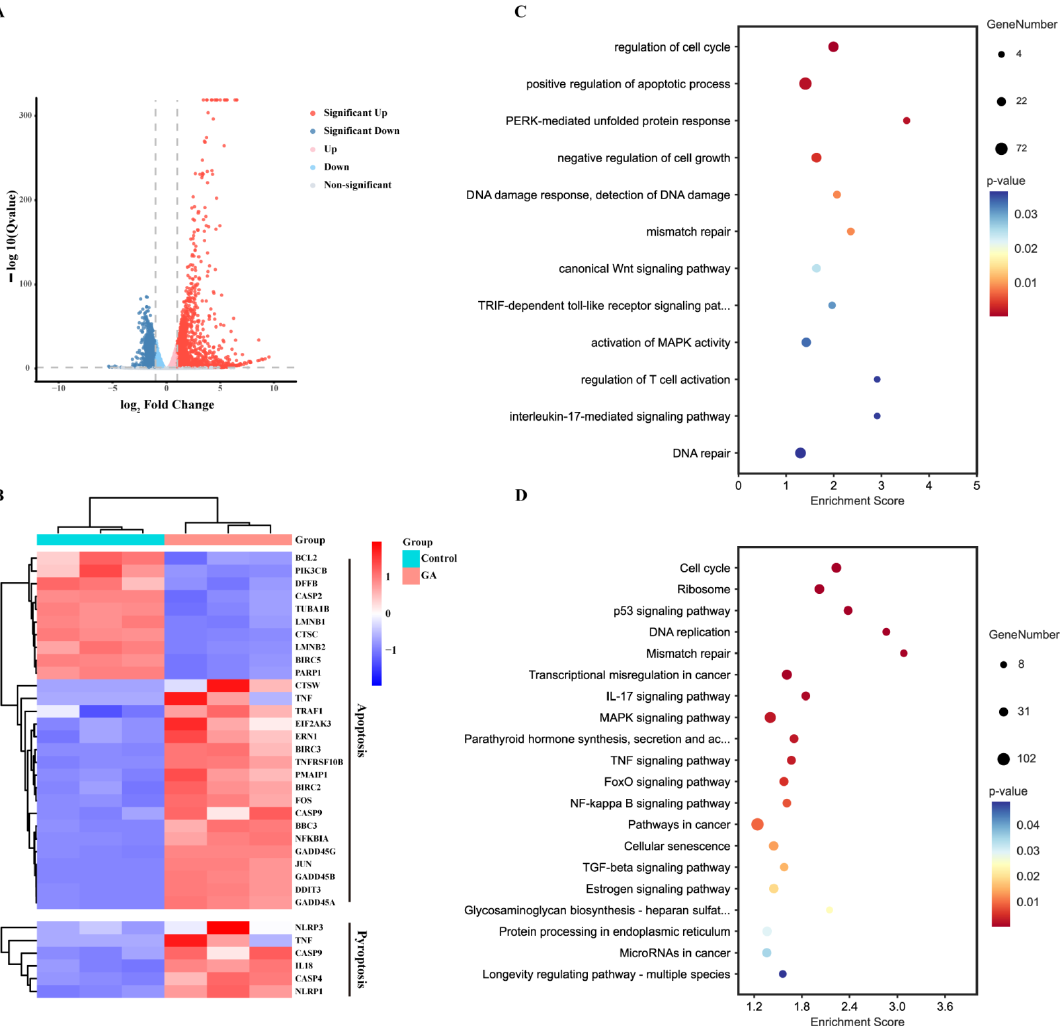
Figure 3. RNA sequencing analysis. ( A ) Volcano plots of differentially expressed genes of HCT116 cells in response to 2 μmol/L GA for 12 h. ( B ) Heatmap analysis of differentially expressed genes involved in apoptosis and pyroptosis. ( C ) GO and ( D ) KEGG enrichment in GA-treated HCT116 cells and control cells. The cells were exposed to 0.1% DMSO as control.